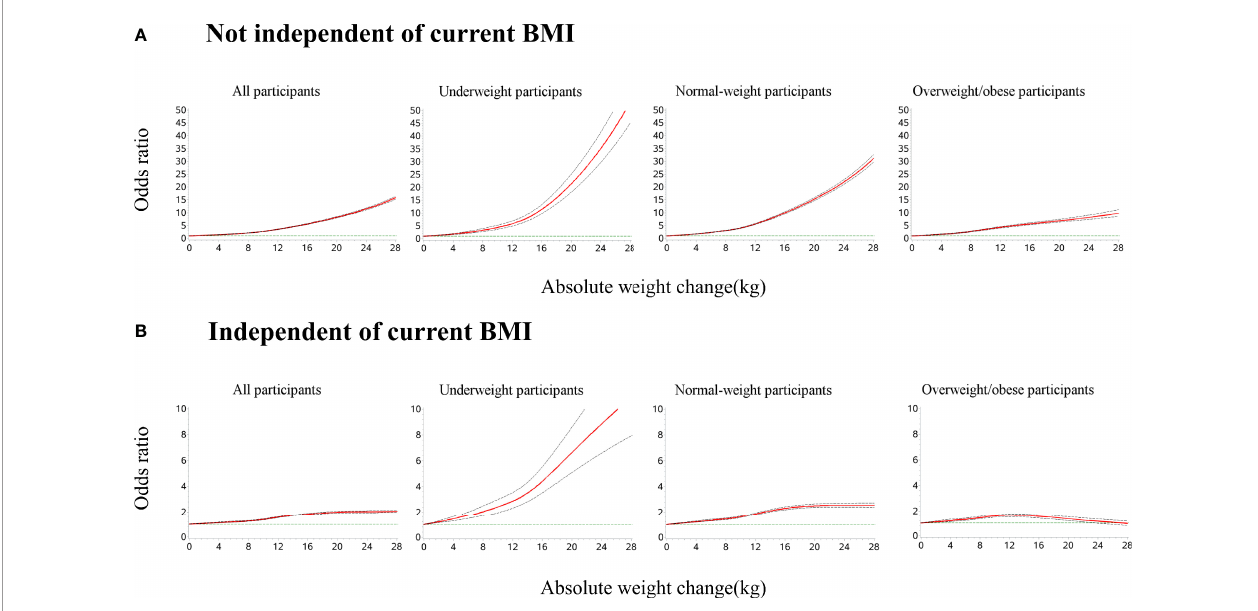
FIGURE 3 | Dose – response association of weight gain from young to middle adulthood with risk of metabolic syndrome across BMI categories at young adulthood. Restricted cubic splines were used with fi ve knots (5th, 35th, 50th, 65th, and 95th centiles). Reference point is 0 kg for weight gain. Odds ratios were indicated by solid lines and 95% con fi dence intervals by dashed lines. (A) All models were adjusted for age, sex, geographic region, urbanity, education level, income, smoking status, drinking status, dietary patterns, leisure time physical activity level, and comorbidities. (B) All models were adjusted for confounders in (A) and current BMI. P for non-linearity <0.001 in all